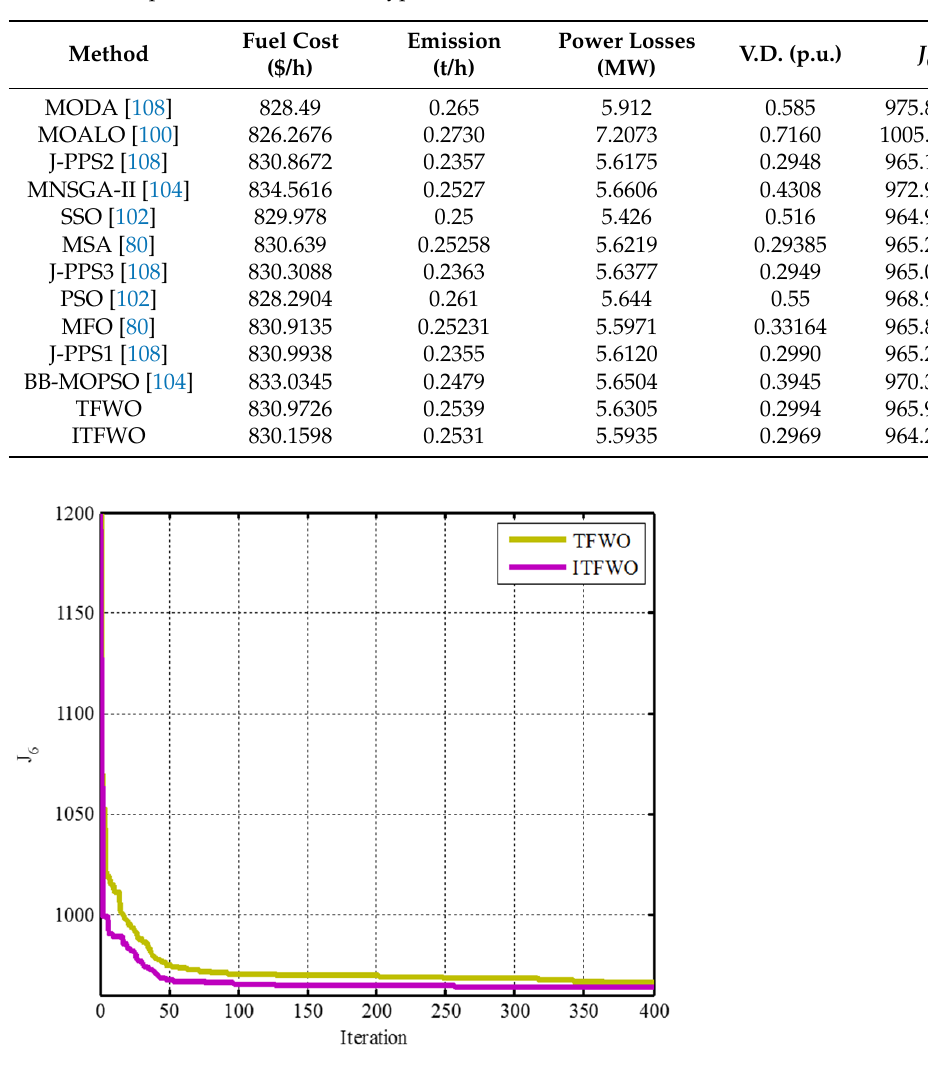
Table 7. The optimization results for Type 6.